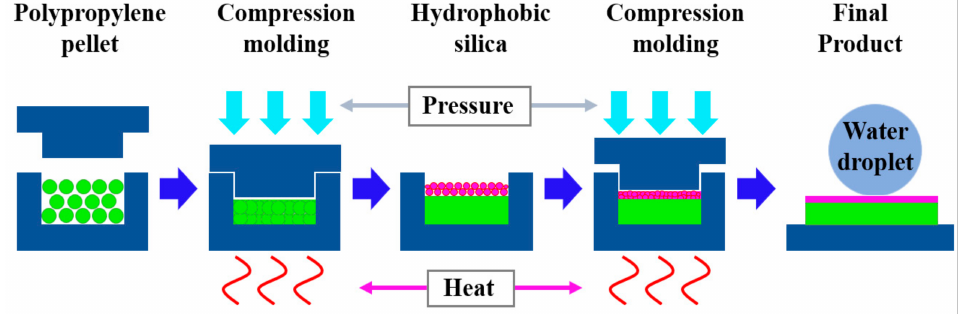
Figure 1. Schematic diagram of the compression molding processes for the superhydrophobic